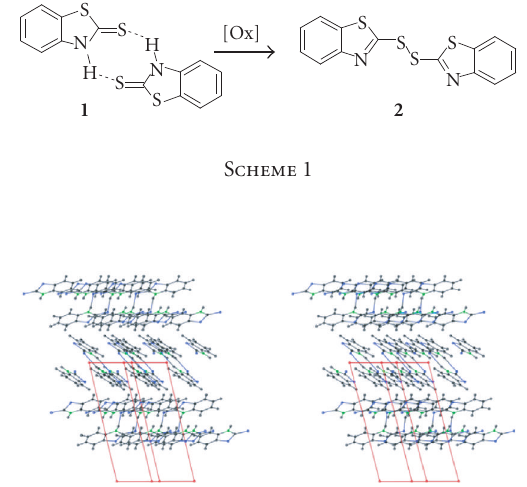
Figure 1: Stereoscopic view of the molecular packing of 2-mercap- tobenzothiazole ( 1 ) with (001) on top showing the flat double lay- ers internally hydrogen-bridged and thus with all functional groups shielded from chemical attack under (001) on the molecular scale.